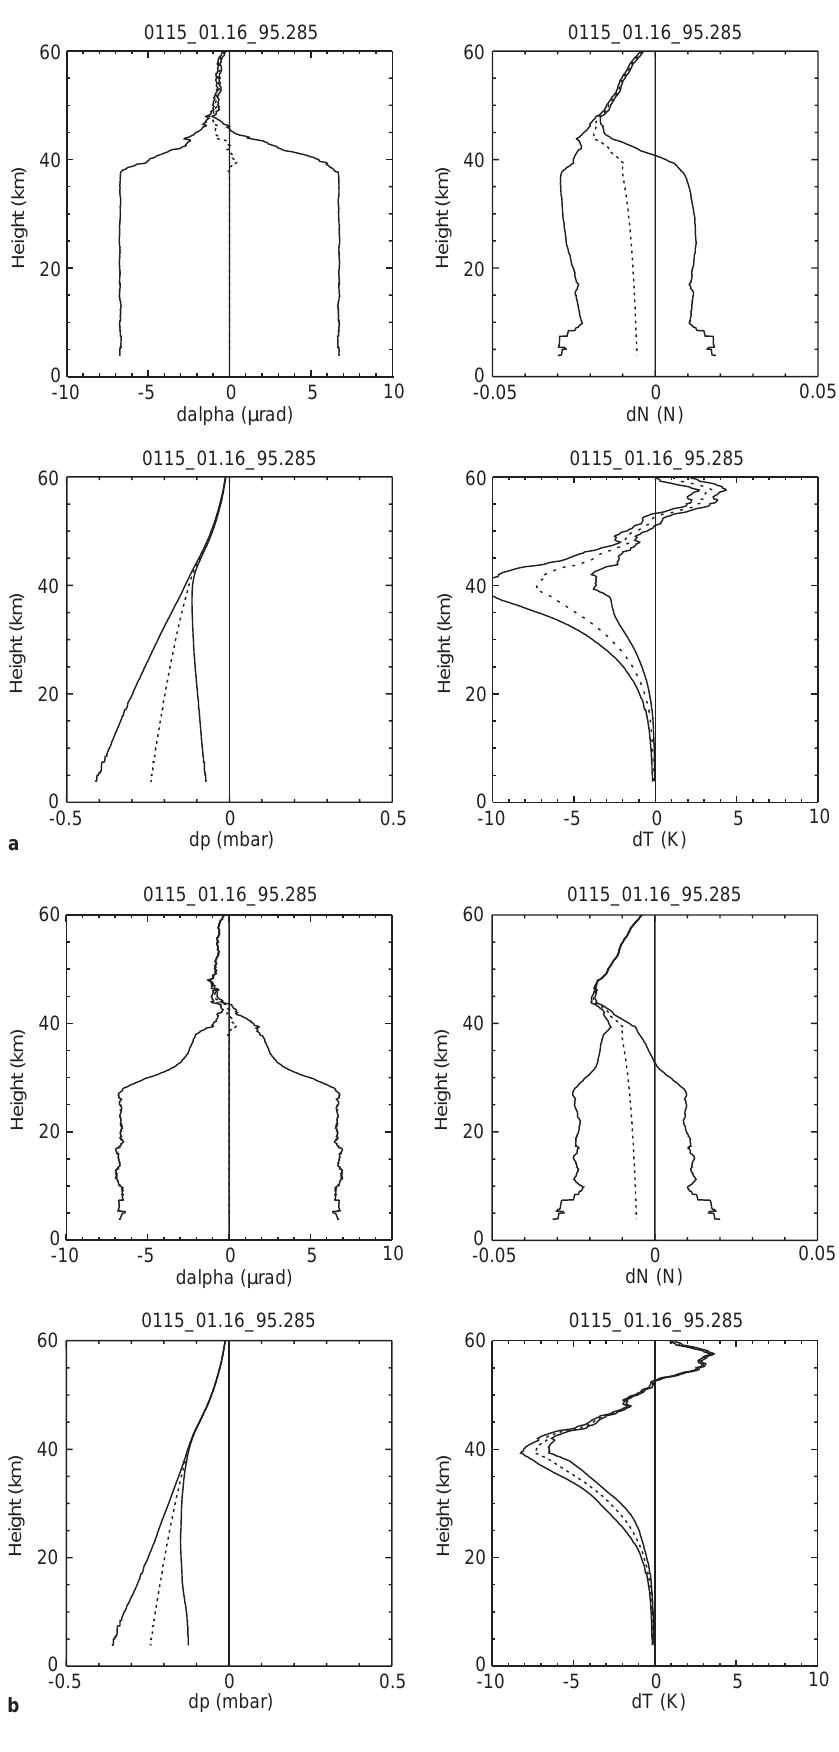
Fig. 8a, b. Results of error estimation analysis taking into account statistical bending angle error plus a systematic bending angle error of 5% in the a priori data used in the statistical optimization ( upper left panel ). The resulting errors in refractivity ( upper right panel ), pressure ( bottom left panel ) and temperature ( bottom right panel ) are shown. a Shows the errors incurred if the systematic error is applied and the GPS/MET bending angle data are weakly filtered only. Applying the same systematic error but more appropriate filtering of the GPS/MET bending angle data between 30 km and 70 km leads to the errors shown in b. The GPS/MET data used are the same as in